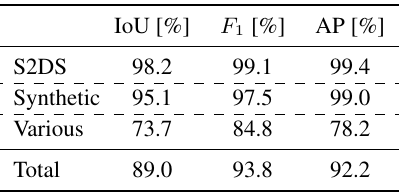
Table 2. Performance of the detection approach on the test data.